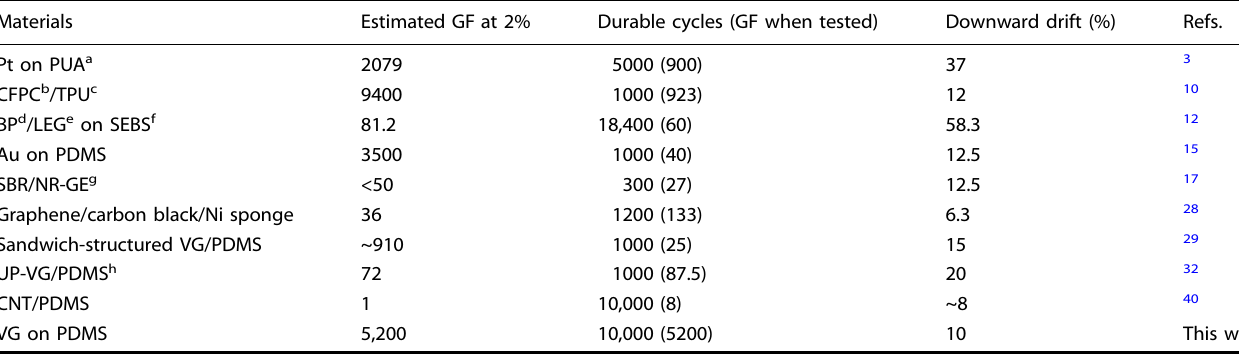
Table 1. Summary of performance comparison for state-of-the-art strain sensors. Materials Estimated GF at 2% Durable cycles (GF when tested) Downward drift